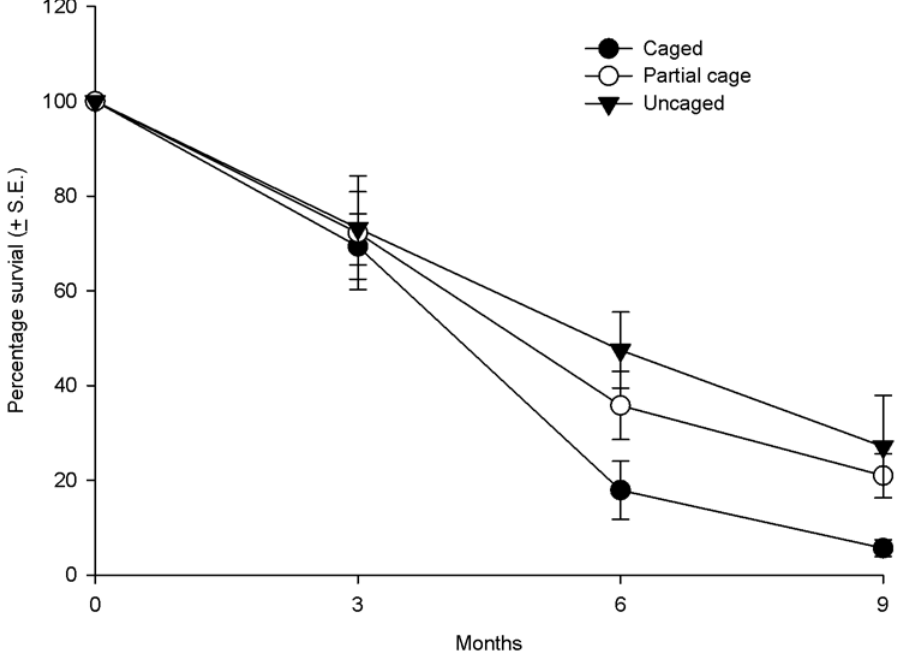
Fig 3. Average survival of coral recruits in the different treatments (uncaged, partially caged and caged) over a nine month period in the post settlement